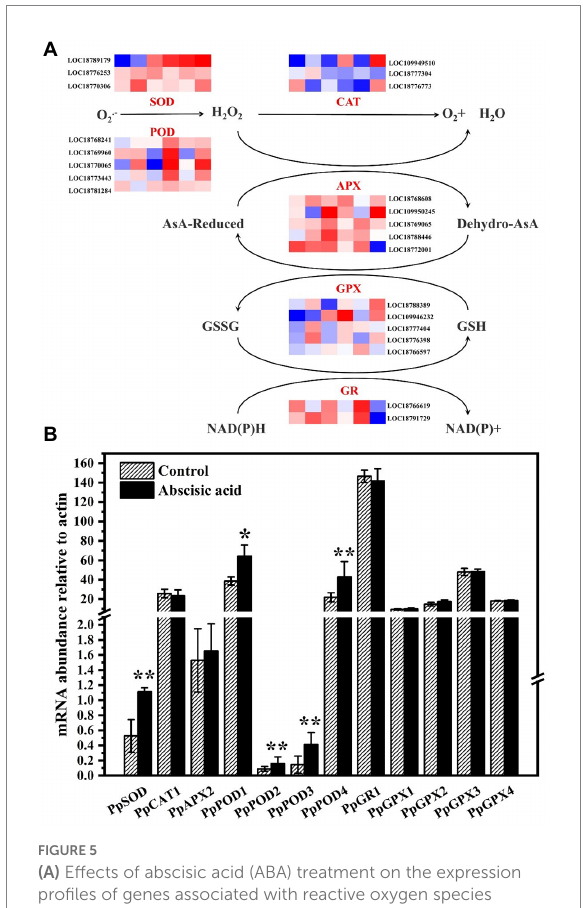
FIGURE 5 (A) Effects of abscisic acid (ABA) treatment on the expression profiles of genes associated with reactive oxygen species metabolic pathways in peach fruit stored at 4 ° C. The rows in each heat map represent the indicated genes, and the six columns indicate the following storage times (left-to-right): CK_21dA, CK_21dB, CK_21dC, ABA_21dA, ABA_21dB, and ABA_21dC. The colors represent the FPKM values between different samples in the heat map. Each value represents the mean for three replicates. SOD, superoxide dismutase; POD, peroxidase; CAT, catalase; APX, ascorbate peroxidase; GPX, glutathione peroxidase; GR, glutathione reductase, monodehydroascorbate reductase. (B) Validation of mRNA abundances of sugar metabolism genes as determined using RT-qPCR. Data are means of three biological replicates ± SE. The symbol (*) indicates significant differences among different treatments at p < 0.05. The symbol ( ** ) indicates significant differences among different treatments at p <